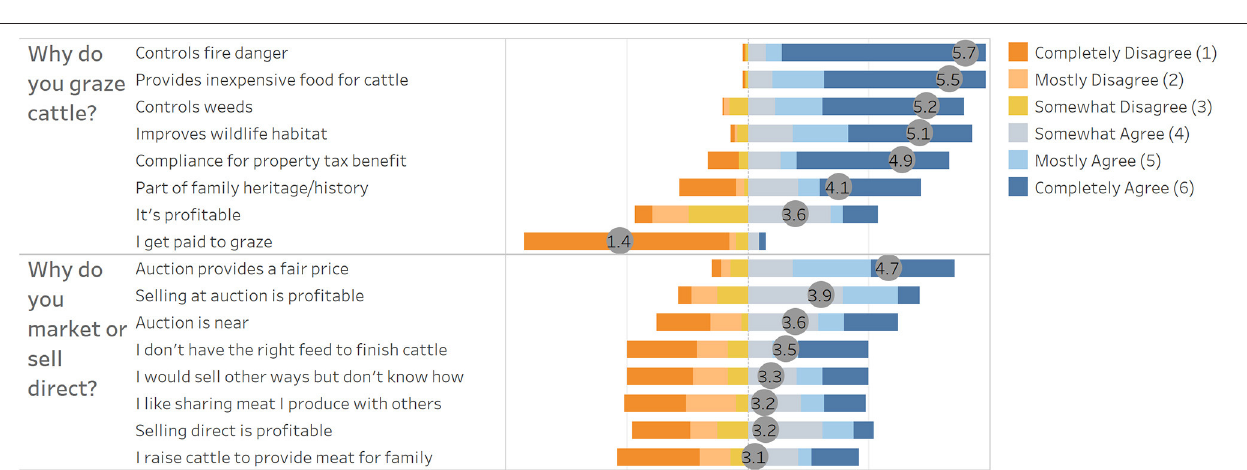
FIGURE 6 | Destinations of beef cattle traveling from California grazing lands to grass (out-of-state) or to feedyards (2017), excludes cattle sold at saleyards.